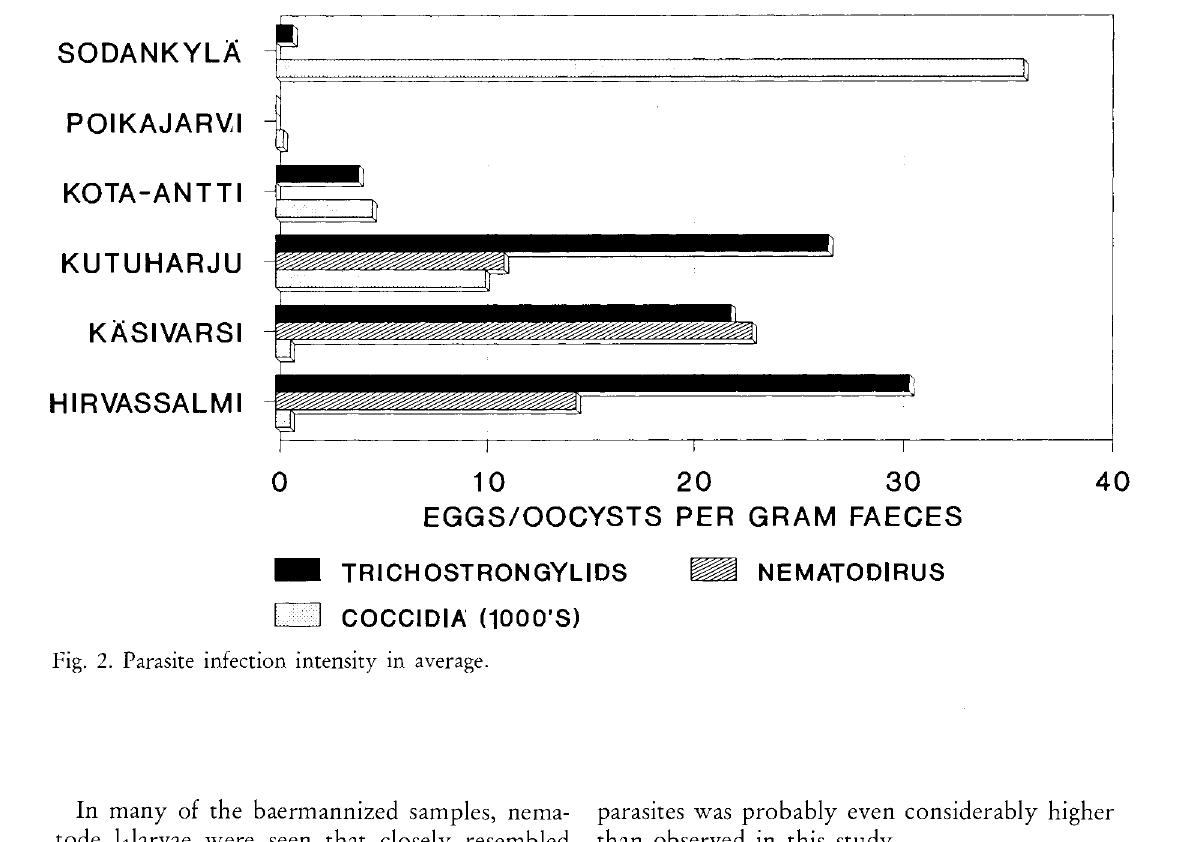
Fig. 2. Parasite infection intensity in